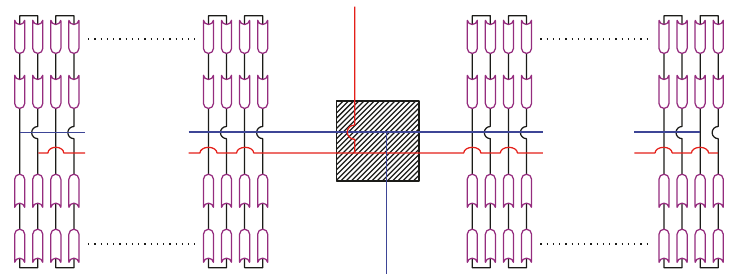
Figure 2: Collector loop con fi guration in the solar fi